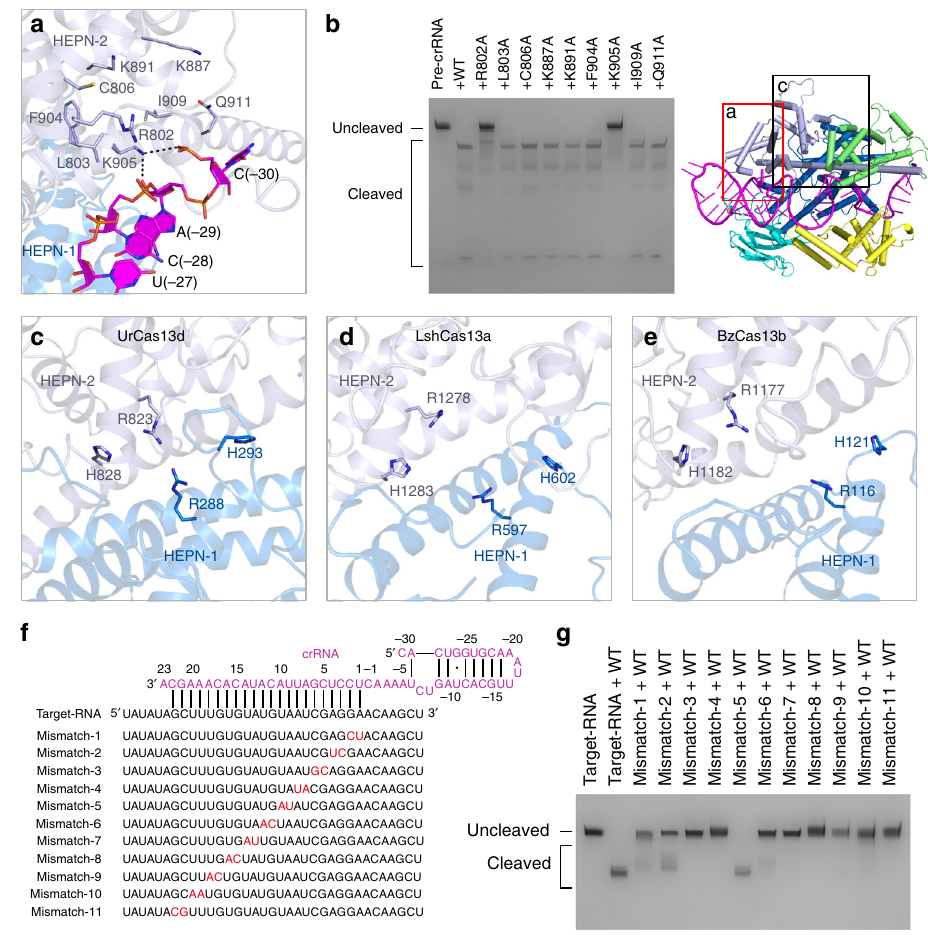
Fig. 6 Active sites involved in pre-crRNA processing and target cleavage. a Close-up view of UrCas13d active site for pre-crRNA processing. Hydrogen bonds are shown as dashed lines. Domains and residues are colored according to Fig. 1. b Denaturing gel shows pre-crRNA cleavage by wild-type UrCas13d and the mutants speculatively involved in pre-crRNA processing. c Close-up view of UrCas13d active site for target RNA cleavage (PDB code: 6IV9). Residues A288 and A823 of the UrCas13d R288A/R823A binary complex was virtually mutated back to R288 and R823. d Close-up view of LshCas13a ( Leptotrichia shahii Cas13a) active site for target RNA cleavage (PDB code: 5WTK). e Close-up view of BzCas13b ( Bergeyella zoohelcum Cas13b) active site for target RNA cleavage. Residue A1177 of the BzCas13b R1177A binary complex (PDB code: 6AAY) was virtually mutated back to R1177. f Schematic representations of crRNA, target RNA and the mismatched targets designed for testing the mismatch tolerance between the crRNA spacer region and target RNA in UrCas13d. g Denaturing gel demonstrating the cleavage of target RNA and the mismatched target RNAs by wild-type UrCas13d in complex with